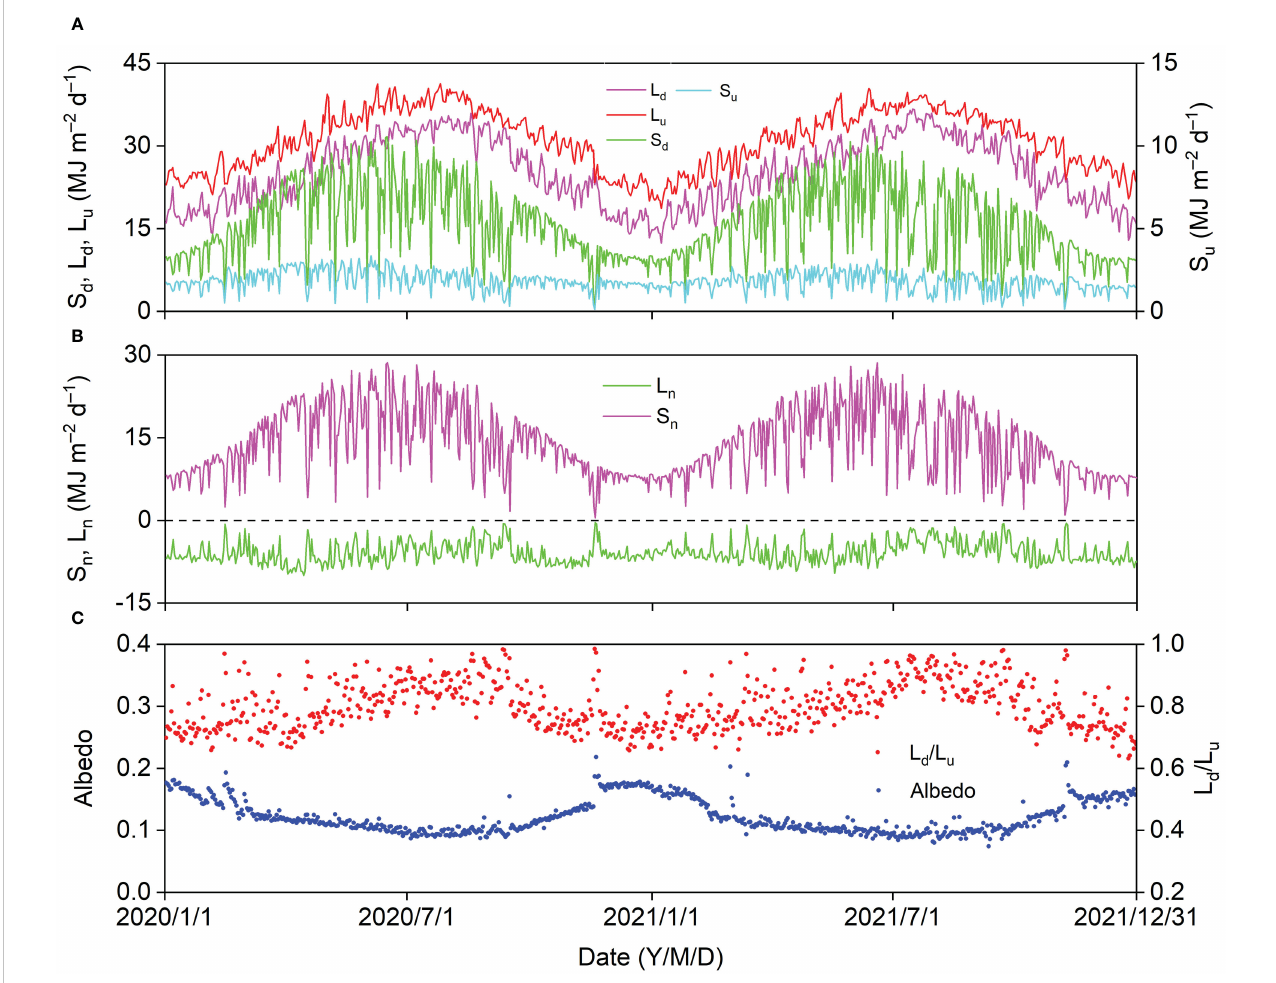
FIGURE 4 Seasonal variation in (A) downward and upward shortwave radiation (S d , S u ), downward and upward longwave radiation (L d , L u ), (B) net shortwave and longwave radiation (S n , L n ), and (C) albedo (S u /S d ) and L u /L d in 2020 and